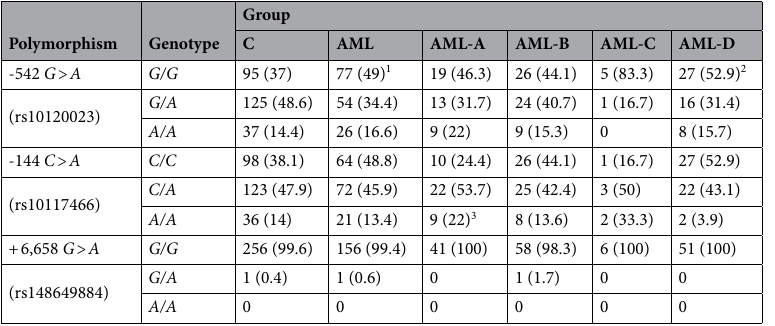
In contrast, ACG and GAG haplotypes were commoner in the AML than in the C group. The last mentioned was particularly frequent within the AML-A group (significant difference in comparison with C as well as AML-B groups). Furthermore, the frequency of both ACG and GAG variants was higher in AML-D in comparison with the control group while an inverse relationship (also in the case of combined AML group) was found for the AAG variant (Supplementary Table 1). Median serum ficolin-1 concentration in AML patients before starting chemotherapy was almost fivefold lower than in healthy controls (260 ng/ml vs. 1,277 ng/ml; p < 0.000001, Mann–Whitney U -test), irrespective of complications recorded during hospital stay or FCN1 genotype (Fig. 1A, 2A, B). The lowest median before start- ing treatment was noted in patients who suffered from hospital infections accompanied by bacteremia/fungaemia after chemotherapy (151 ng/ml) (Fig. 1A). Furthermore, lower ficolin-1 before chemotherapy seemed to predict prolonged fever: the median for patients who experienced fever for > 7 days was as low as 119 ng/ml while for the other patients, it equalled 284 ng/ml ( p = 0.026). However, that result was not statistically significant after Bonferroni correction. Furthermore, there was no association with mortality. Low ficolin-1 levels (< 620 ng/ml) were therefore very common among patients with AML (71.8%) in com- parison with healthy controls (10.2%) [ p < 0.00001, OR = 23.4, 95% CI (13.64–40.2)]. The difference remained highly significant after multiple logistic regression analysis and Bonferroni correction [ p < 0.001 OR = 38.2 95% CI (17.57–83.04)]. Consequently, the highest frequency (82.9%) of low ficolin-1 was associated with the most severe infections [ p < 0.000001, OR = 44.7, 95% CI (17.95–111.3) vs. C group]. However, concentrations < 620 ng/ml were often noted in other patients’ subgroups as well. Even in uncomplicated cases (n = 50), their frequency equalled 66% [ p < 0.000001, OR = 17.9, 95% CI (8.73–36.55) vs. controls]. We observed no significant differences in the frequency of high (> 2.9 μg/ml) concentrations (AML: 2.6% vs. C: 5.1%). Interestingly, although ficolin-1 levels correlated with white blood cell (WBC) and more weakly with platelet (PLT) counts (r = 0.49, p < 0.000001 and r = 0.24, p = 0.003, respectively), high leukocytosis was often associated with low ficolin-1. It should be however stressed that no correlation (r = 0.05, p = 0.53) with absolute neutrophil count (ANC) was observed. As shown in Fig. 2A, B, serum ficolin-1 concentrations in the AML group were not associated with FCN1 gene SNP at posi- tions − 542 and − 144 while for the control group, expected trends were apparent (lower levels related to variant alleles), although the differences between carriers of various genotypes were not significant. FCN2 gene polymorphisms and serum concentrations of ficolin‑2. We found no significant differ- ences in FCN2 genotypes or allele distribution between patients and controls (Table 2). Reconstruction of haplo- types revealed AACG (including major alleles at positions − 64, − 4, + 6,359 and + 6,424) to be the most common in both AML and C groups. Together with the AGTG variant, it accounted for approx. 80% of haplotypes in each group/subgroup (Supplementary Table 2). The AACG haplotype was found especially often among patients who had no infective complications during hospital stay ( p = 0.029 vs. controls). However, that result was not statisti- cally significant after correction for multiple comparisons. Despite lack of differences between patients and controls in the frequency of FCN2 genotypes, the median ficolin-2 concentration in the AML group (4.69 µg/ml) was significantly higher than in the controls (3.38 µg/ ml, p < 0.000001, Mann–Whitney U -test). In the specific case of the exon 8 SNP, despite apparent trends, the differences between variant homozygotes (+ 6,359 C > T ) or heterozygotes (+ 6,424 G > T ) were not statistically significant perhaps due to their relatively low numbers (Fig. 2E, F). The highest values were associated with infec- tions whether accompanied by bacteremia/fungaemia (4.69 µg/ml; p = 0.00006) or not (5.05 µg/ml; p < 0.000001) (Fig. 1B). Unusually, in 10 (6.4%) patients, ficolin-2 level exceeded 10 µg/ml (maximal value 13.6 μg/ml). No